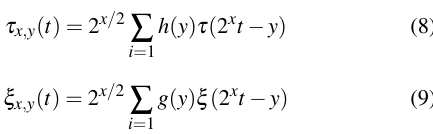
Figure 5: Flow-Diagram